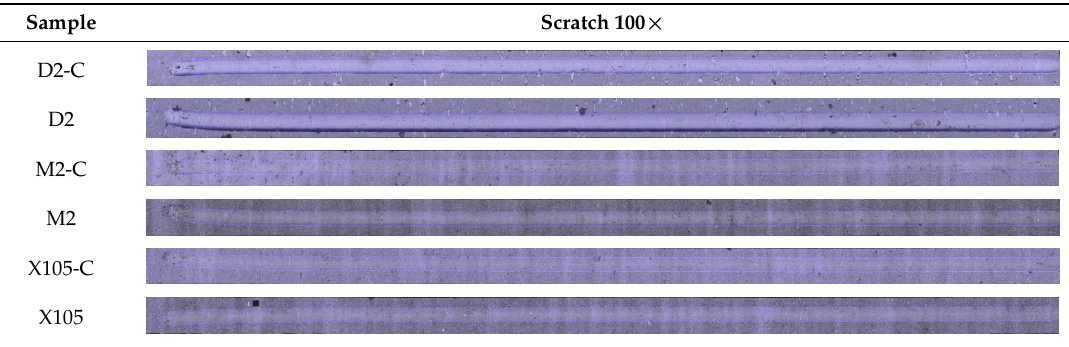
Table 5. Optical micrographs of scratches. 100 × magnifications.